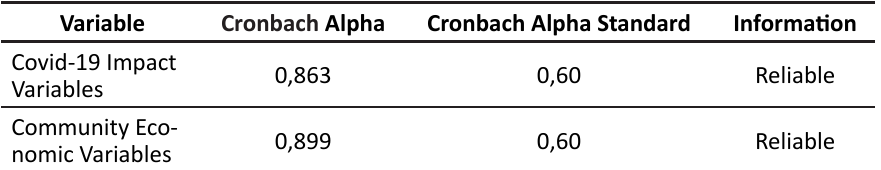
Table 6: Reliability Test